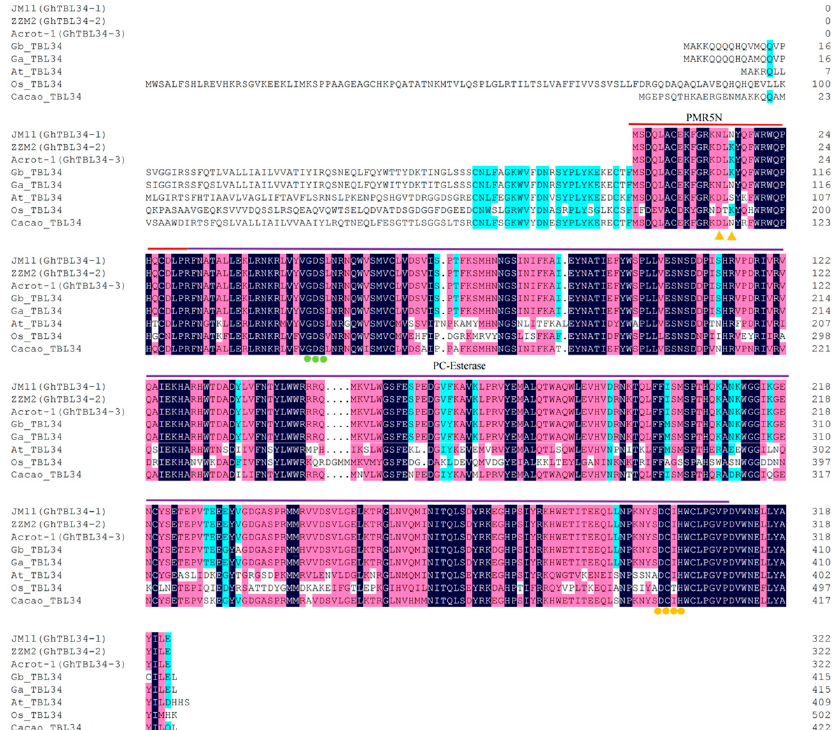
Figure 5. Multiple sequence alignment of GhTBL34-1 , GhTBL34-2 protein, and TBL34 proteins from other species. Note: The two amino acid differences located in the TBL (PMR5N) domain between GhTBL34-1 and GhTBL34-2/-3 are marked with yellow triangle. The red and purple solid lines represent the conserved domains of PMR5N and PC-Esterase, respectively; the green and yellow dots are the conserved motifs of GDS and DXXH,